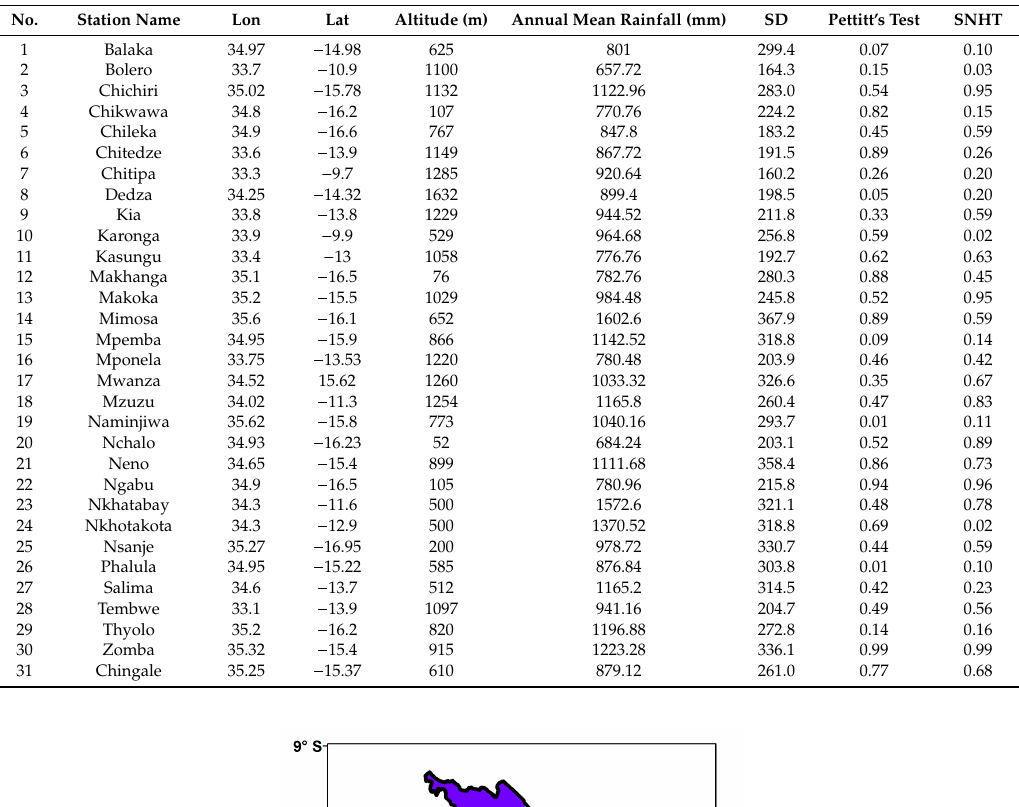
Table 1. Geographical features, annual mean rainfall, standard deviation (SD), Pettit’s test, and SNHT for the rainfall stations during the period 1979–2015.